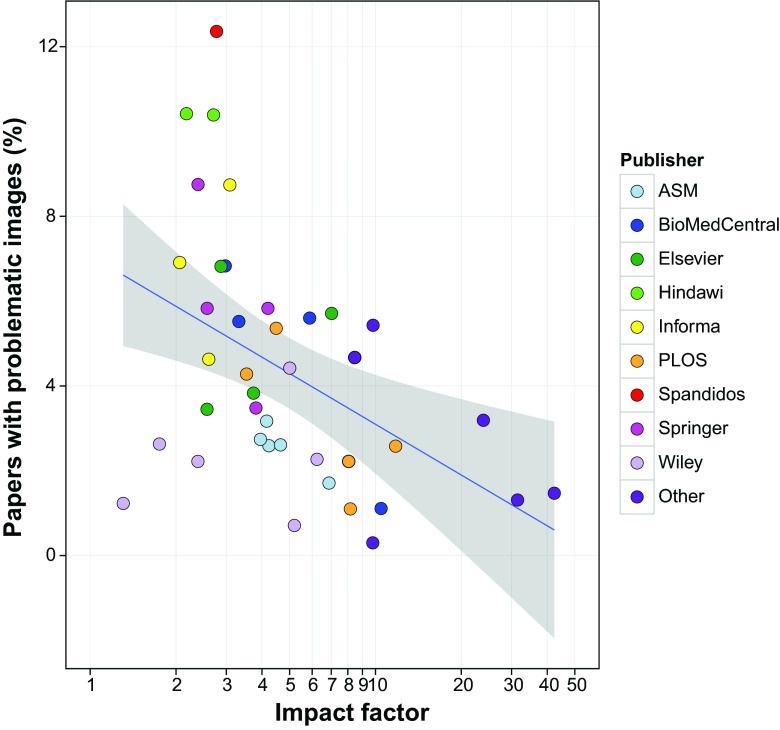
Correlation between journal impact factor and percentage of papers with image duplication. Only papers from 2005 to 2014 (n = 17,816) were included in this analysis. Each data point represents a journal included in this study (n = 40), with data points color-coded according to the publisher (n = 14; journals published by AAAS, Nature, Cell Press, the National Academy of Sciences, and the Rockefeller University Press are grouped under “other.”) The x axis is shown on a logarithmic scale due to the small number of journals with a high impact factor included in this study. The blue line shows a linear regression model. The gray zone depicts the 95% confidence interval.